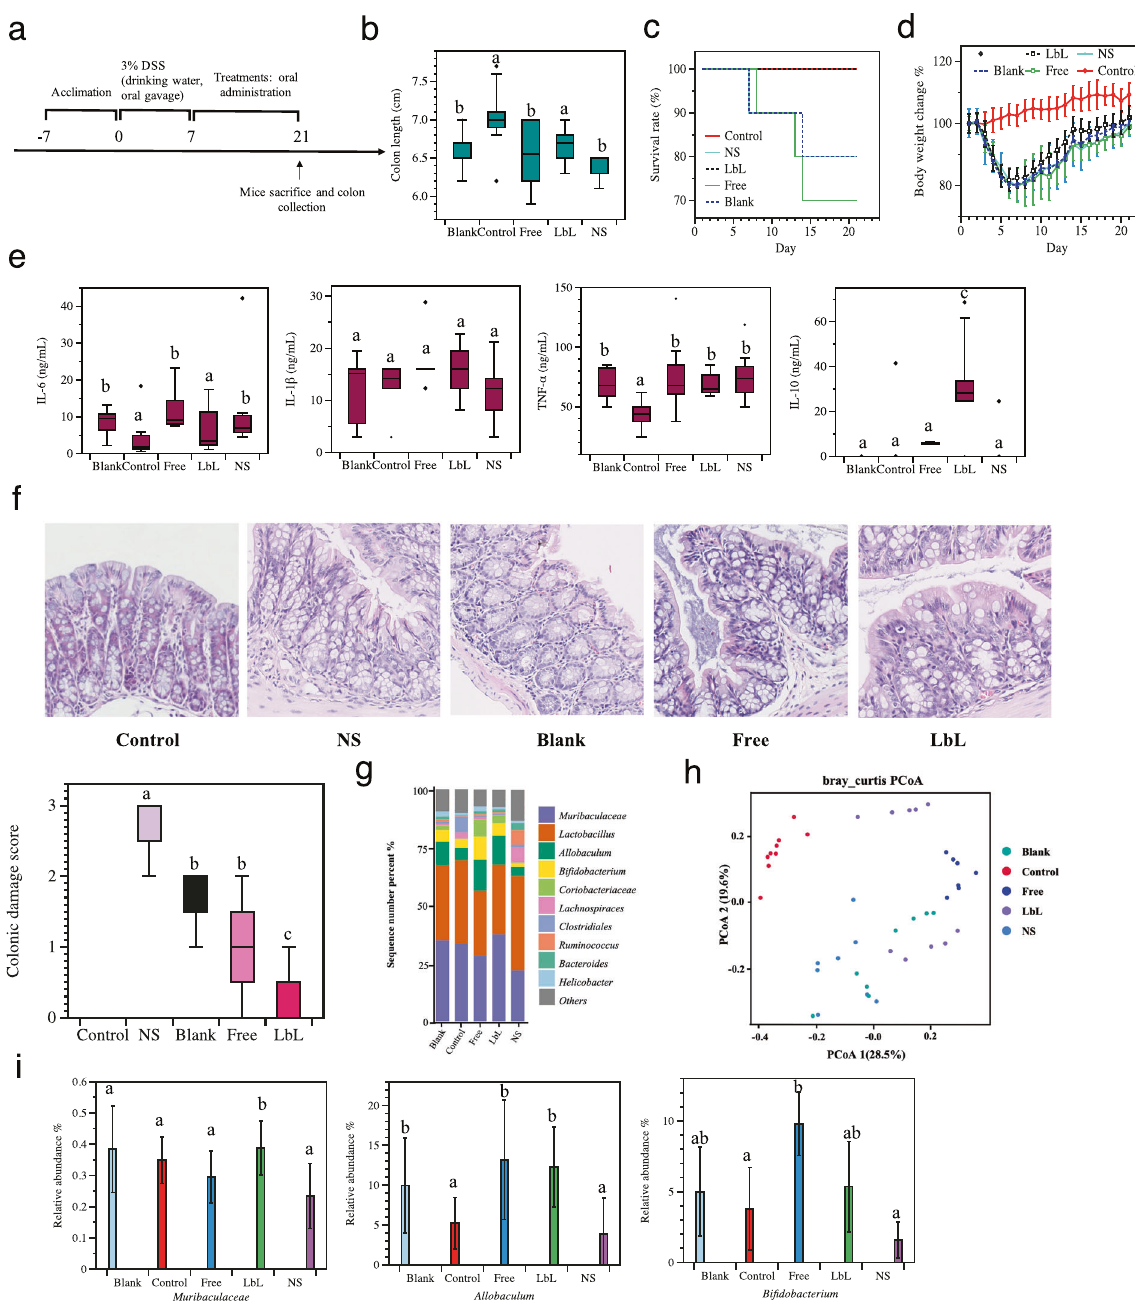
Fig. 5 Effects of Li01 treatment of mice with dextran sulfate sodium (DSS)-induced colitis. a Chart describing the steps in the DSS-induced colitis mouse model. On the 8th day, mice were strati fi ed on whether they were orally administrated with saline (NS), chitosan and alginate mixture (Blank), non-encapsulated Li01 (Free) or LbL encapsulated Li01 (LbL) for 14 days. b – d Colon length, mouse survival rate, and daily body weight changes were measured in each treatment group. ( e ) Concentrations of in fl ammatory cytokines were measured in the plasma in DSS colitis-induced mice. f Images of colonic damage were recorded, and colonic damage scores were measured in DSS colitis-induced mice. g , i Colonic microbiota pro fi les and relative abundances of unique microbial taxa following treatment were determined with 16S rRNA-based metagenomic analysis. h Microbial clustering is shown based on Bray – Curtis dissimilarity Principal Coordinates Analysis (PCoA) metrics of colic fecal samples of DSS-induced mice after treatment. Data in the fi gures are presented as mean ± SEM. Different letters represent signi fi cant differences ( P ≤ 0.05) between